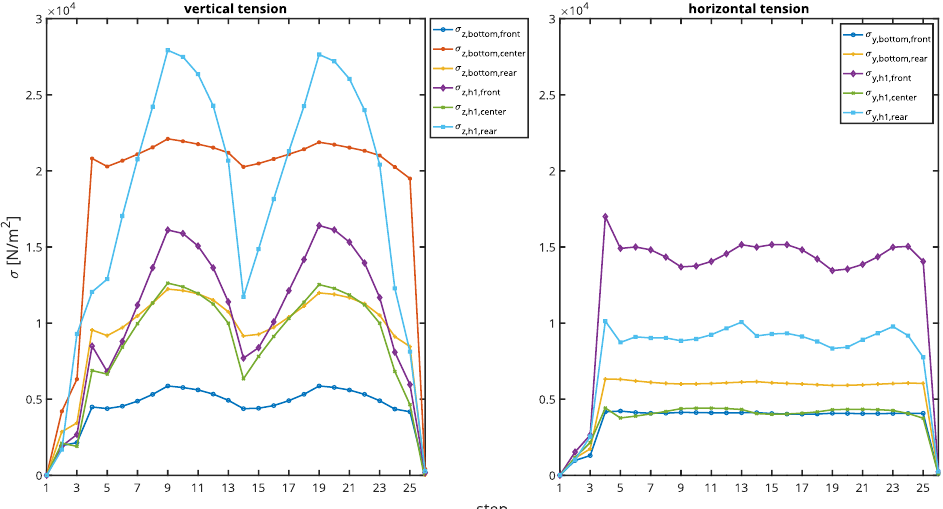
Figure 7. Vertical and horizontal pressure values in the box for each step of the test program.